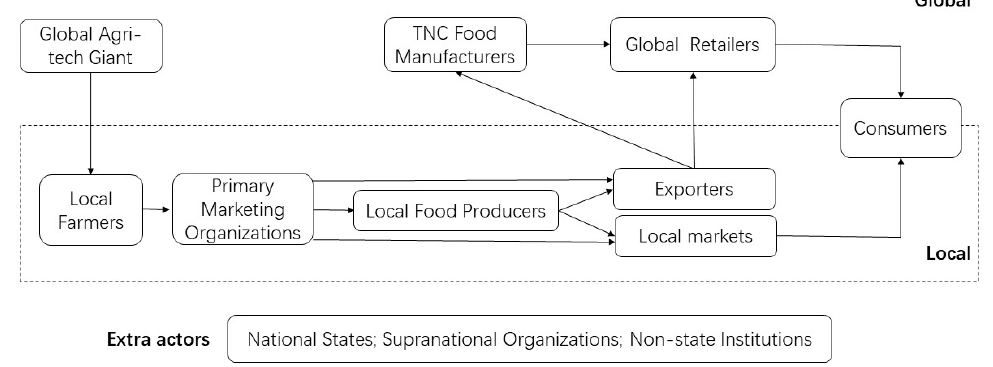
Figure 1. Global agricultural production networks.